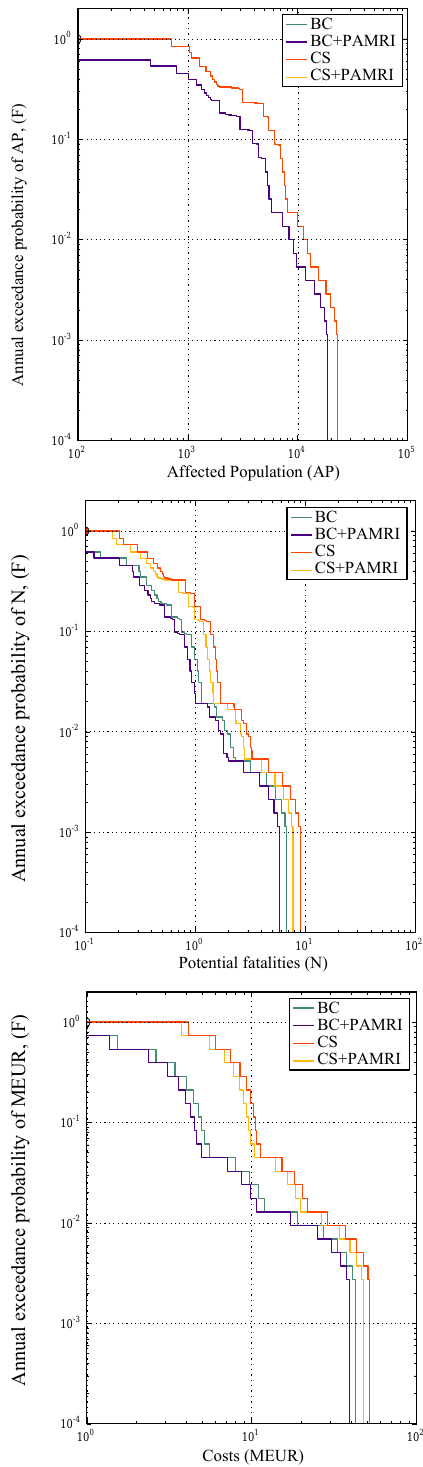
Figure 7. Extract of F-AP, F-N, and F-D curves for the case study: scenarios 0 (current situation), scenario 1 (PAMRI = local action plan), scenario 2 (structural measures), and scenario 3 (PAMRI and structural